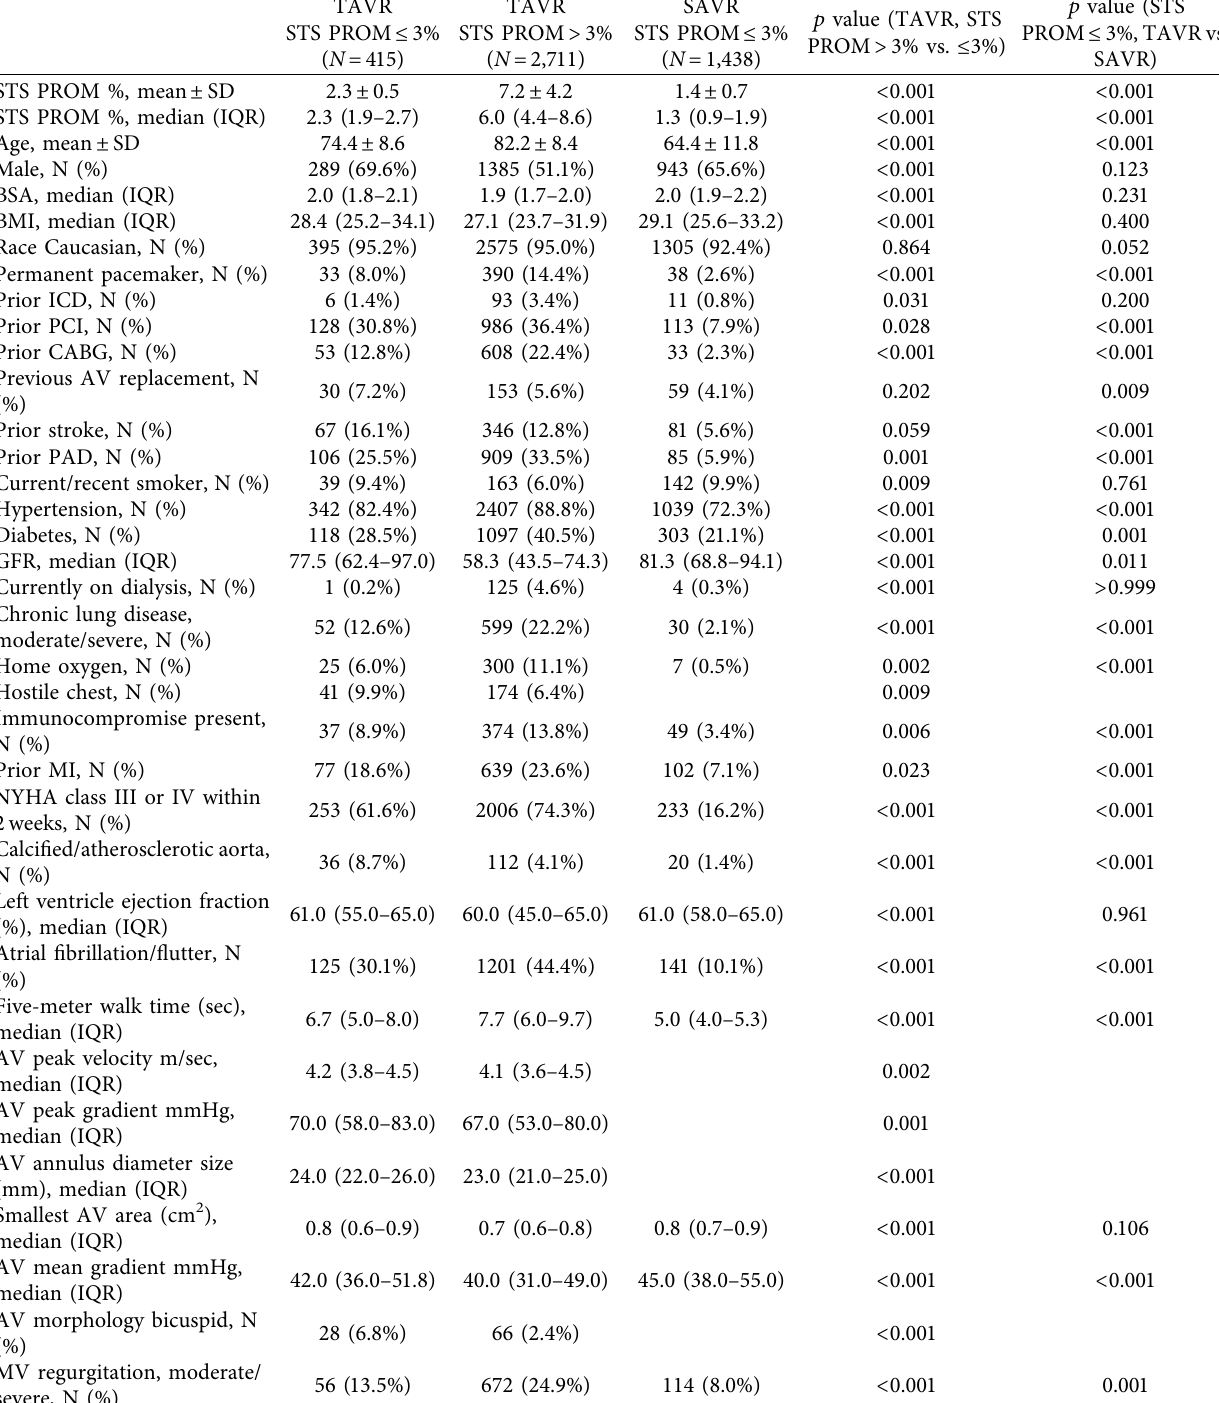
Table 1: Baseline demographic and clinical characteristics by study groups. Blank responses in the SAVR group represent data not collected in STS Adult Cardiac Surgery